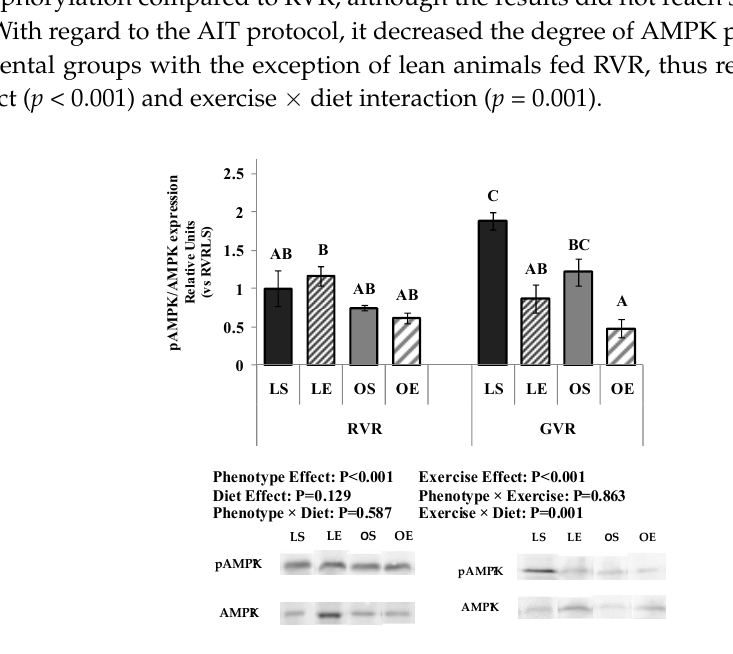
Figure 6. Effect of dietary treatment with raw or 4 day-germinated V. radiata and aerobic interval training protocol on AMPK α /pAMPK α protein expression in the liver of lean and obese Zucker rats measured by Western blot analysis. AMPK, 5 (cid:48) -AMP-activated protein kinase; phosphorylated-AMPK, pAMPK. RVR, raw V. radiata , GVR, 4 day-germinated V. radiata . Groups: LS, Lean ( fa /+) sedentary rats, LE, Lean ( fa /+) rats performing aerobic interval exercise, OS, Obese ( fa / fa ) sedentary rats, OE, Obese ( fa / fa ) rats performing aerobic interval exercise. Immunoblots are representative of liver homogenates of eight different rats for each experimental group; all samples were derived at the same time and processed in parallel. The amount of sample loaded per lane was 100 µ g of protein. Levels of pAMPK were normalized to the total AMPK. Densitometric analysis values represented in the graphs are means ± SEM depicted by vertical bars ( n = 8). Means without a common letter differ, p < 0.05.